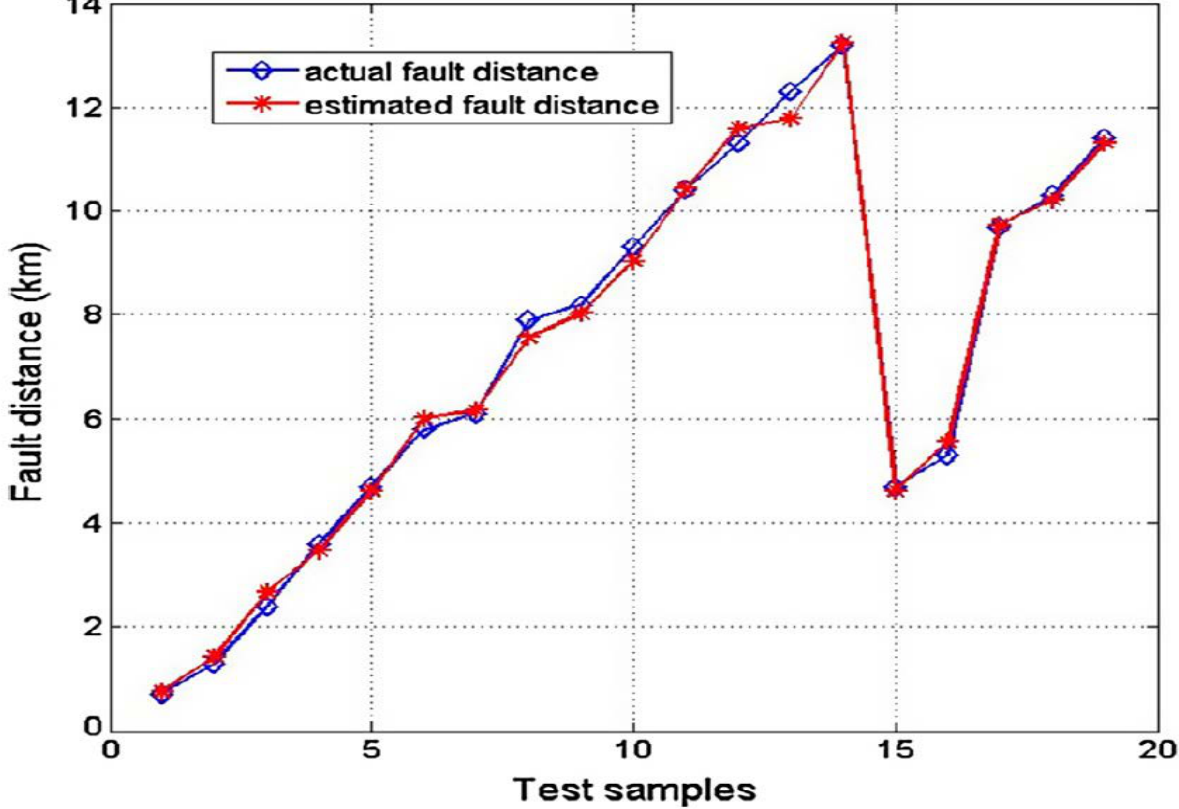
Figure 9. Fault estimation testing sample using SVR.